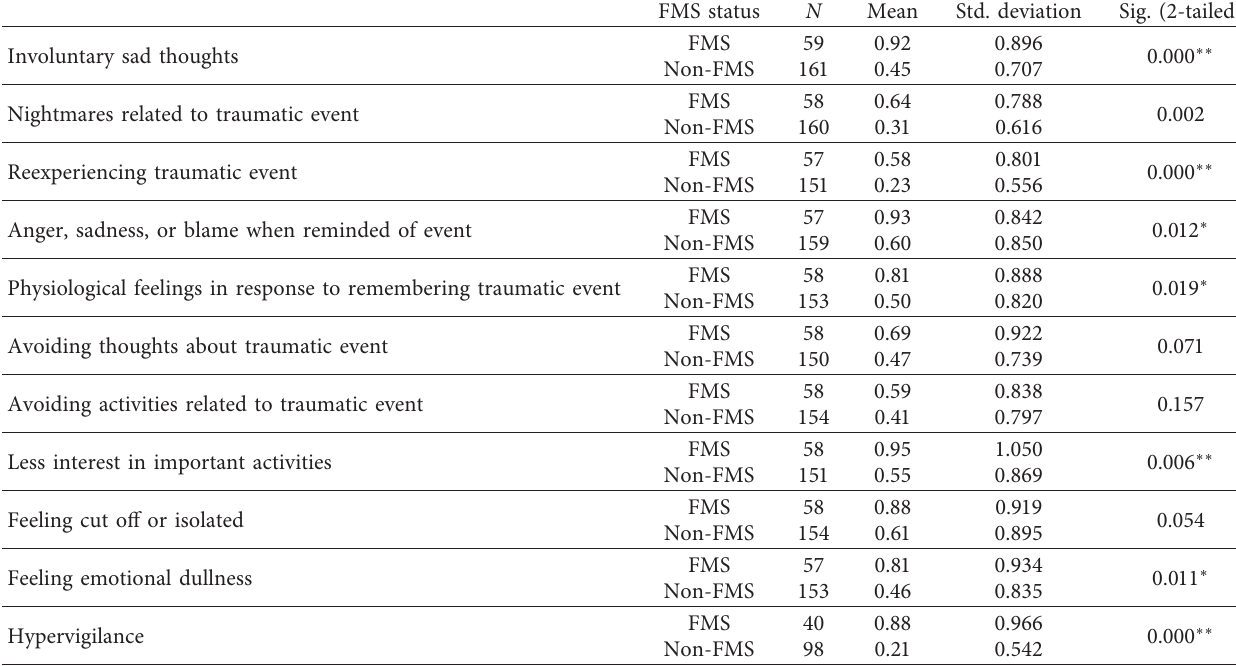
Table 4: Comparison of posttraumatic symptoms between kindergarten teachers with and without